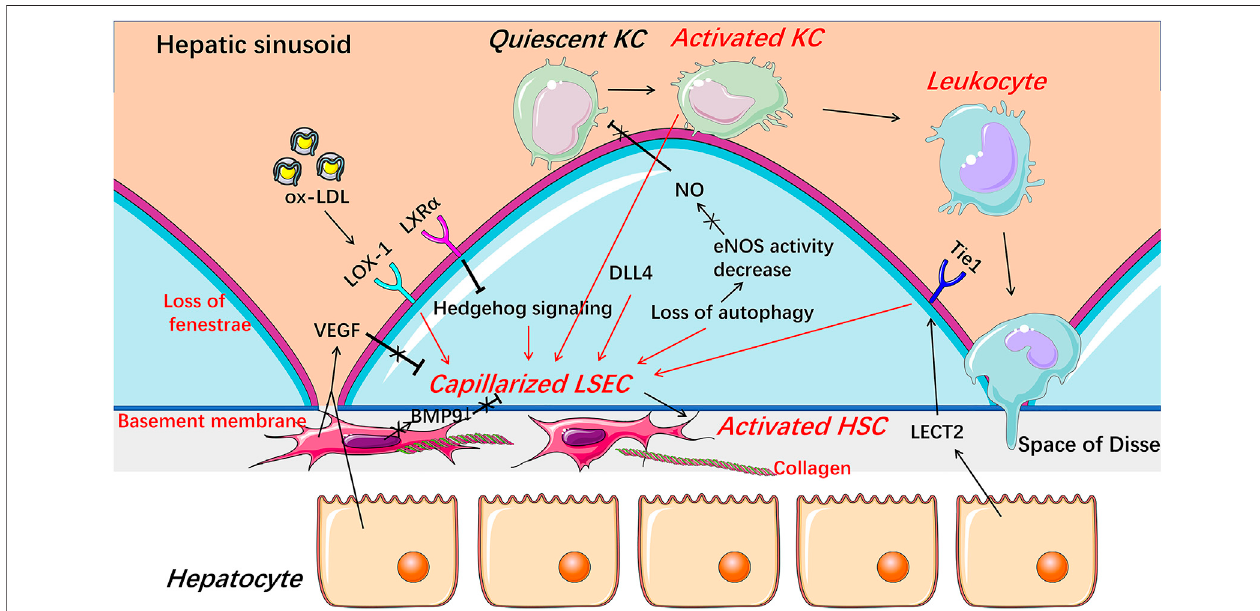
FIGURE3| CapillarizationandendothelialdysfunctionofLSECsunderpathologicalcondition.Wheninjured,LSECsundergocapillarizationrepresentedbytheloss offenestraeandtheformationofbasementmembranewhichareinvolvedinHedgehogsignaling,autophagy,HSCs-derivedBMP9,LSECs-derivedDLL4,andreceptors including LOX-1, LXR α , andTie1. The reduction ofNObioavailabilityisanimportantindicator ofendothelialdysfunction andinvolved intheprogressofthe capillarization of LSECs. Capillarized and dysfunctional LSECs promote the activation of HSCs and KCs and thus promote liver fi brosis and in fl ammation. BMP9 Bone morphogenetic protein 9, DLL4 Delta-like ligand 4, HSC hepatic stellate cell, KC Kupffer cell, LECT2 leukocyte cell-derived chemotaxin 2, LSEC liver sinusoidal endothelial cell, LXR α liver X receptor α , LOX-1 lectin-like oxidized low-density lipoprotein receptor-1, NO Nitric oxide, ox-LDL oxidized low-density lipoproteins, VEGF vascular endothelial growth factor.